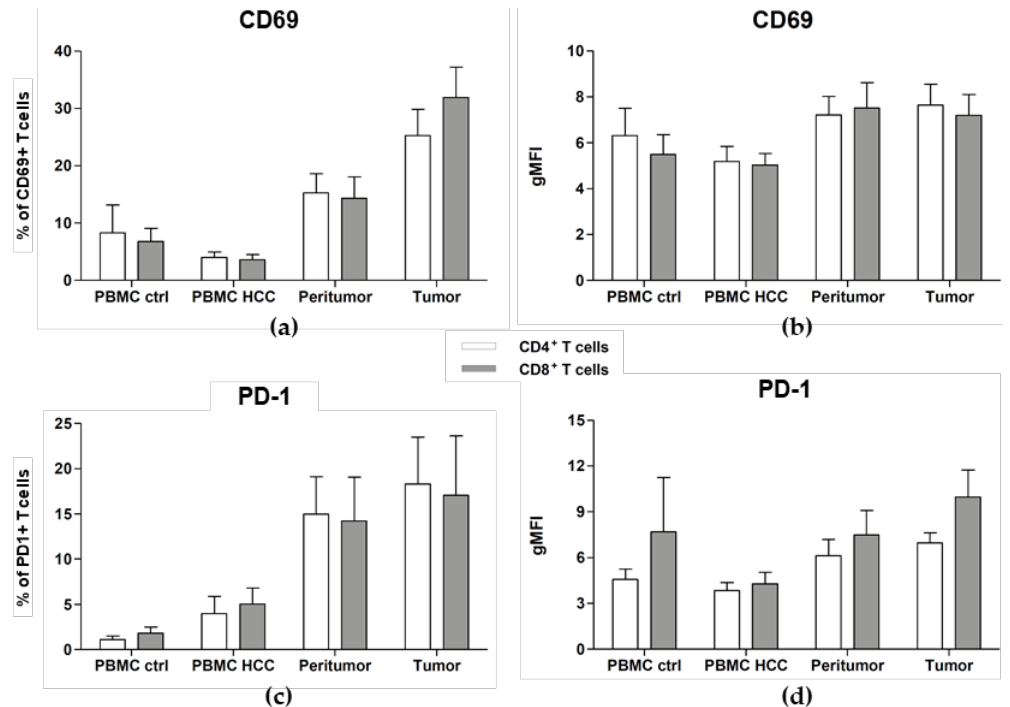
Figure 4. The percentage of PD-1 + and CD69 + T cells are increased in the tumor. Cell suspensions were prepared from PBMC, tumor and peritumor taken during surgery and were analyzed by flow cytometry. PBMC from healthy donors were used as control. The expression of PD-1 and CD69 on T cells from PBMC, tumor and peritumor of each patient and on T cells from PBMC of healthy controls was quantified. ( a ) Percentage of CD69 + CD4 + T cells and CD-69 + CD8 + T cells; ( b ) gMFI of CD69; ( c ) Percentage of PD-1 + CD4 + T cells and PD-1 + CD8 + T cells; ( d ) Geometric mean fluorescence intensity (gMFI) of PD-1. Results are expressed as Mean ± SEM from cumulative results (with n = 9–14 patients or controls). * p < 0.05, ** p < 0.01 and *** p < 0.001 as determined by Mann–Whitney’s test between each lymphoid subset, in each tissue.